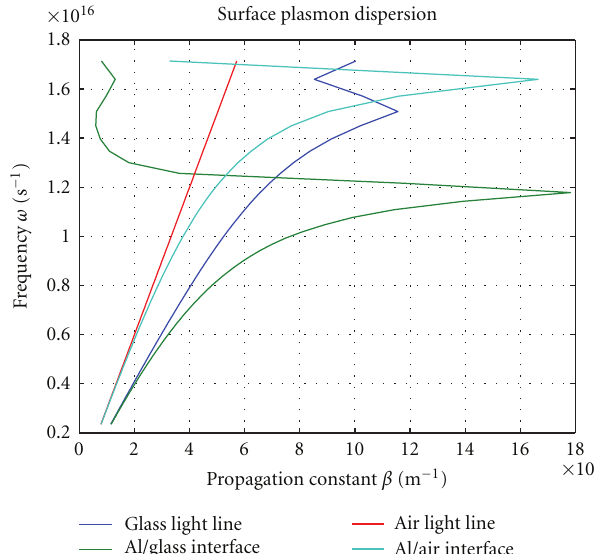
Figure 1: Surface plasmon dispersion curves for Kretschmann ATR configuration, calculated using material properties for Al and SiO 2 from RIT material database [22].